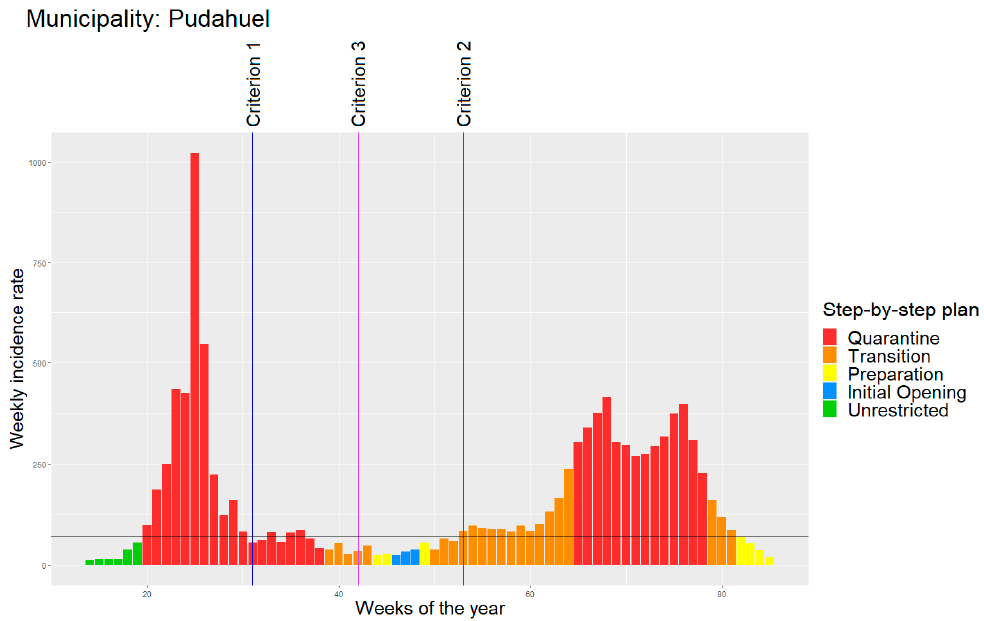
Figure 1. Waves’ identification example: Pudahuel.